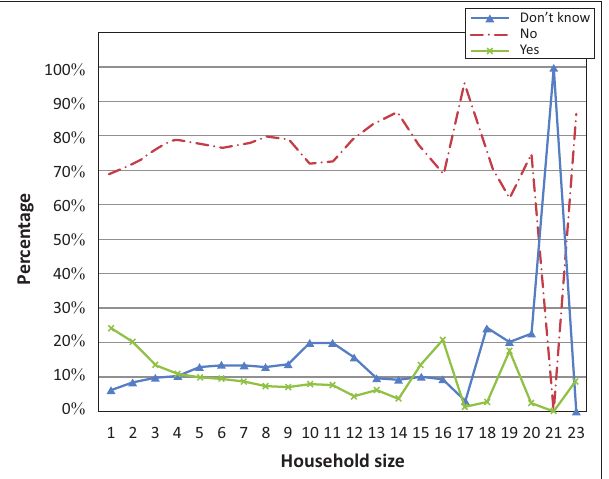
FIGURE 4: Self-reported vision difficulty by household